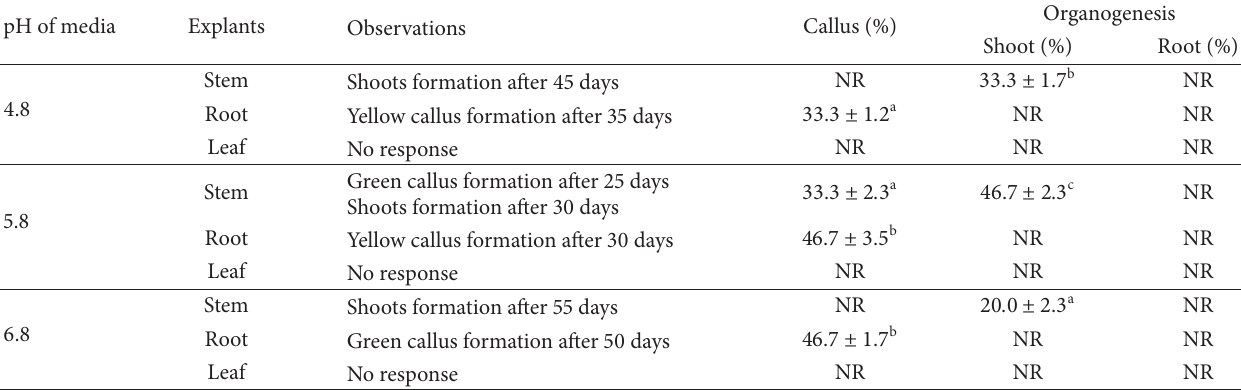
Table 5: The effects of different pH on stem, root, and leaf explants, cultured on optimum media (MS + 1.5mgL − 1 NAA + 2.0mgL − 1 BAP) at 25 ± 1 ∘ C. Cultures were maintained at 16 hours of light and 8 hours of darkness, with 1000 lux intensity of